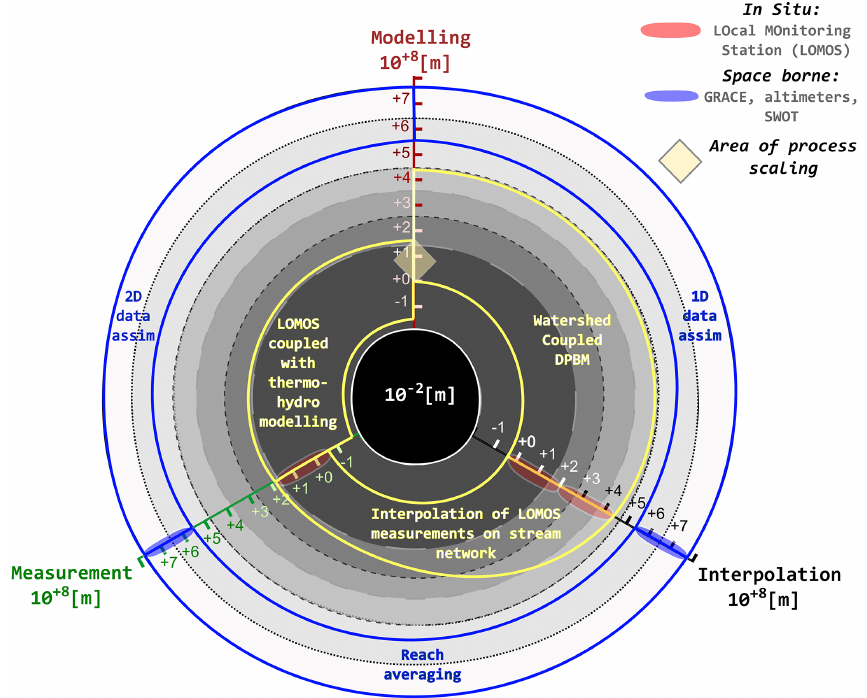
Figure 5. Localisation of two approaches in the MIM methodological space. In yellow: upscaling methodology from the local to the water- shed scale based on LOMOS coupled with DPBM. In blue: regional to continental scales covered by satellite data coupled to assimilation frameworks. Axis in logarithmic scale. data assim: data assimilation.